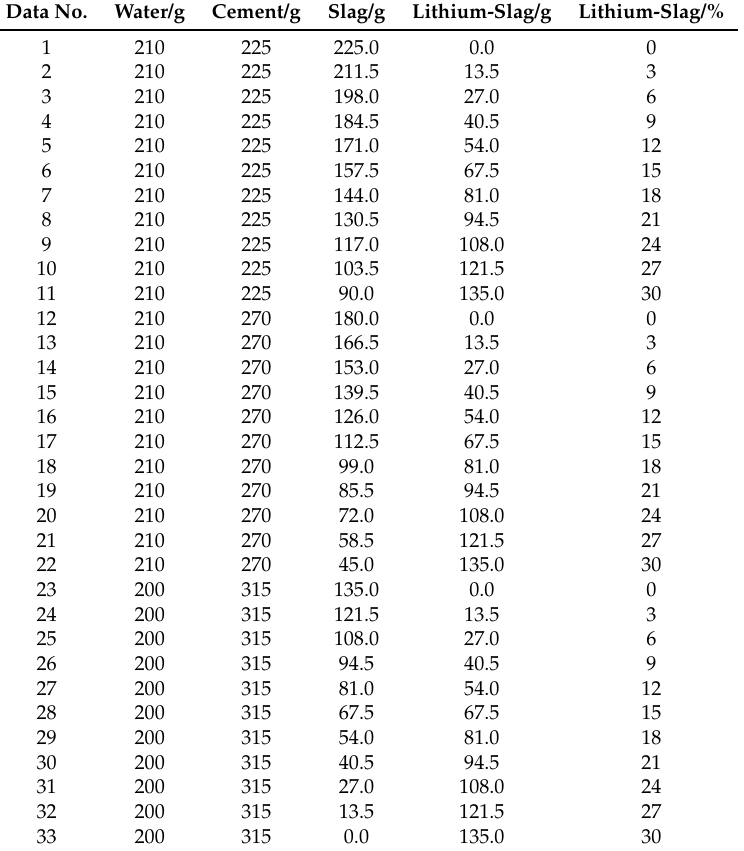
Table 4. Details of mix proportions for lithium-slag and slag cement